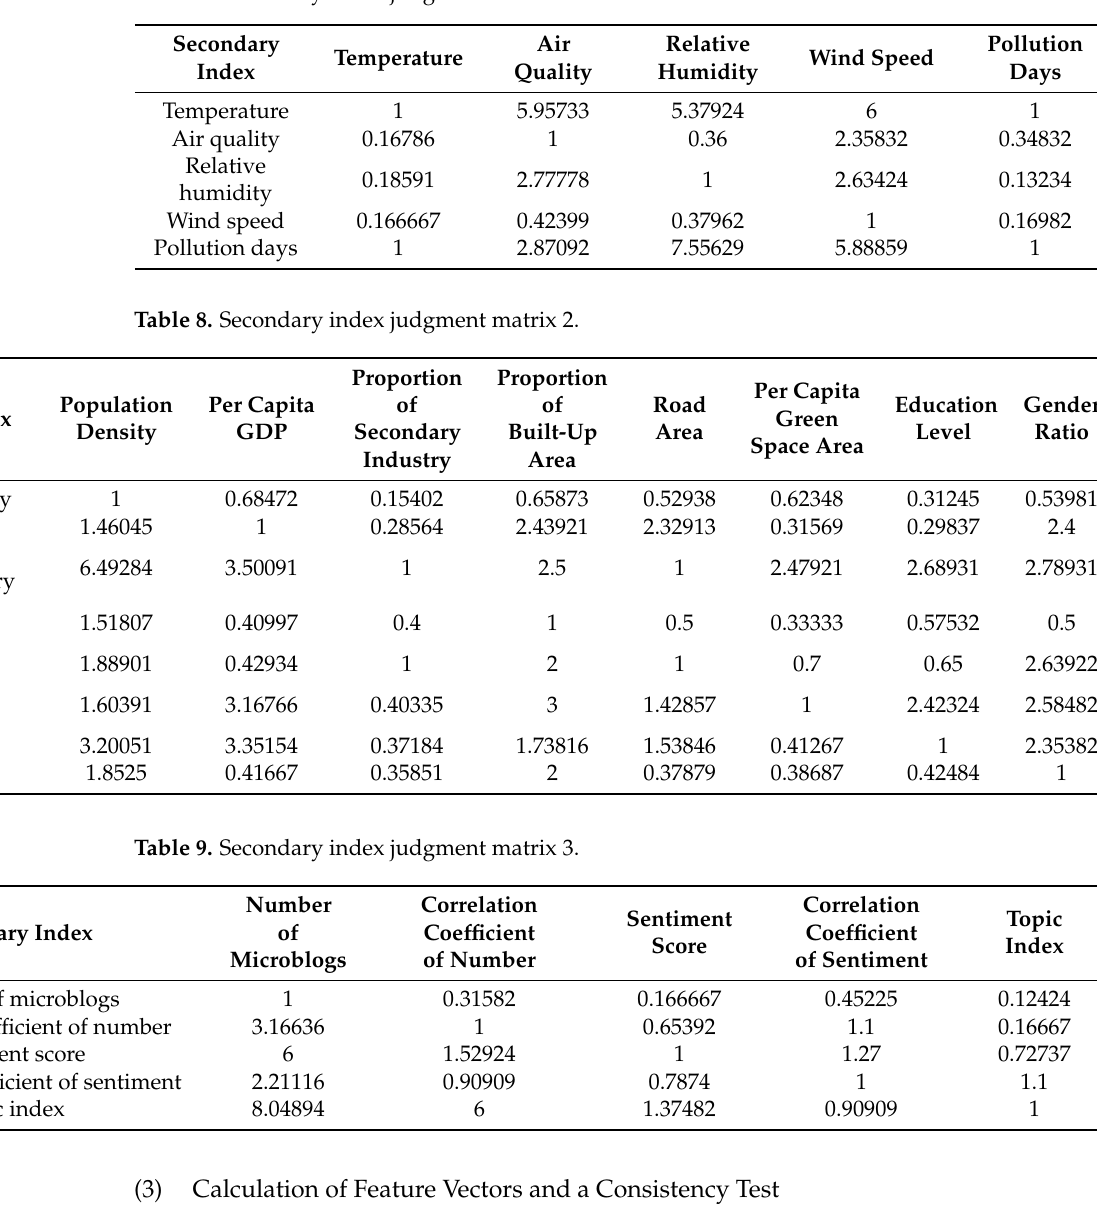
Table 7. Secondary index judgment matrix 1.